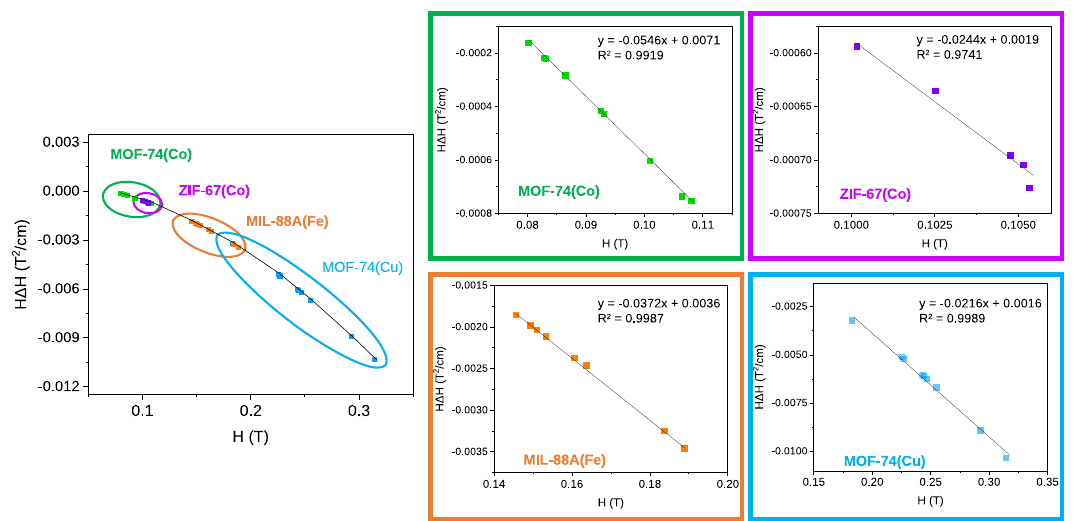
Fig. 3 Dependence of H · ∇ H vs magnetic fi eld. H (cid:2) ∇ H dependence on the magnetic fi eld, H , at the centre of the pole and linear fi tting in the range at which the magnetic sustentation experiments are performed for each